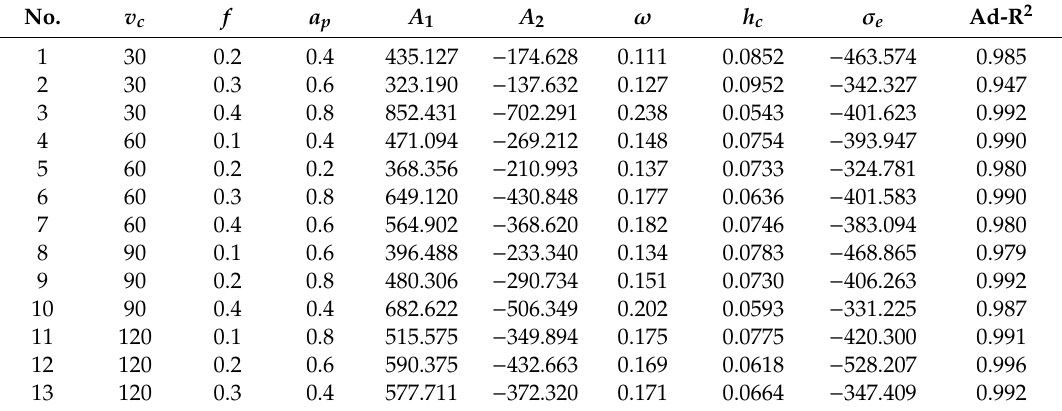
Table 6. The key parameters of axial residual stresses fitting function ( v c : cutting speed in m / min; f : feed rate in mm / r; a p : depth of cut in mm.).